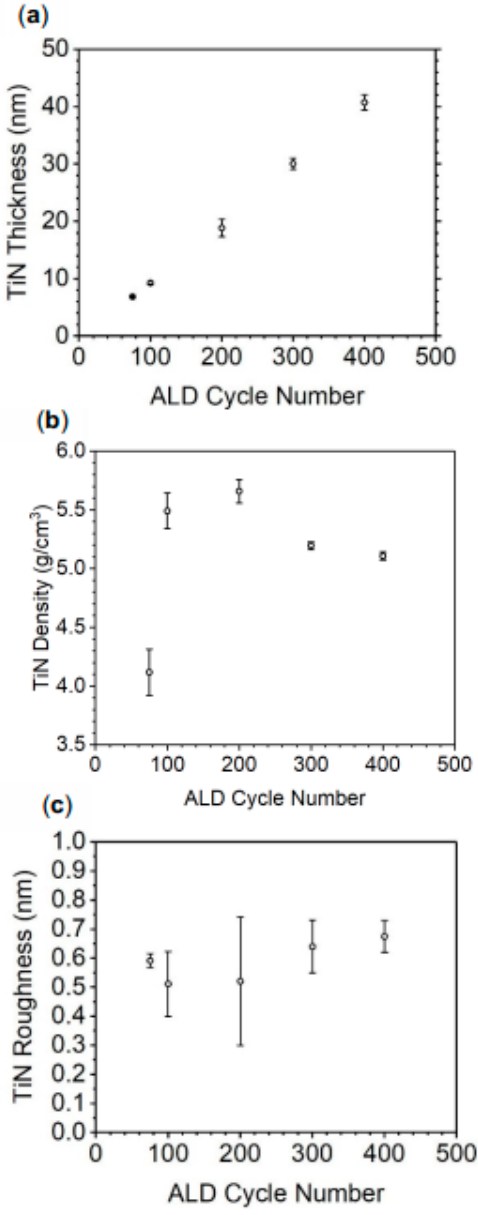
Figure 2. TiN thin film properties from XRR: ( a ) thickness, ( b ) density, and ( c ) roughness as a function of the number of ALD cycles.